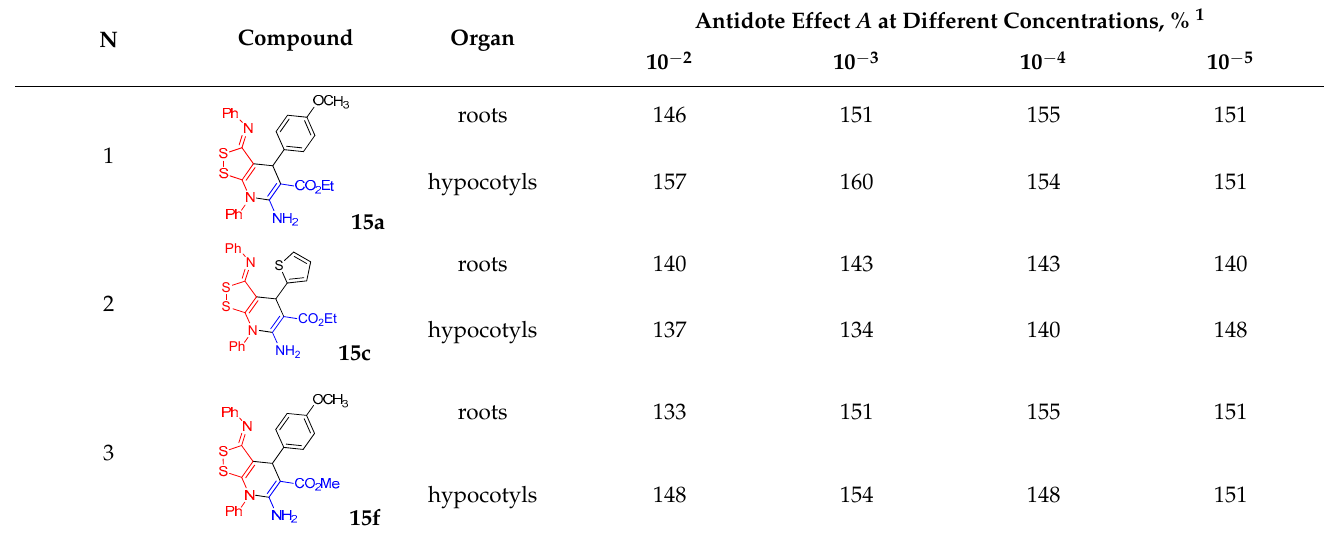
Table 1. The antidote effects of the most active compounds 15a,c,f with respect to herbicide 2,4-D.